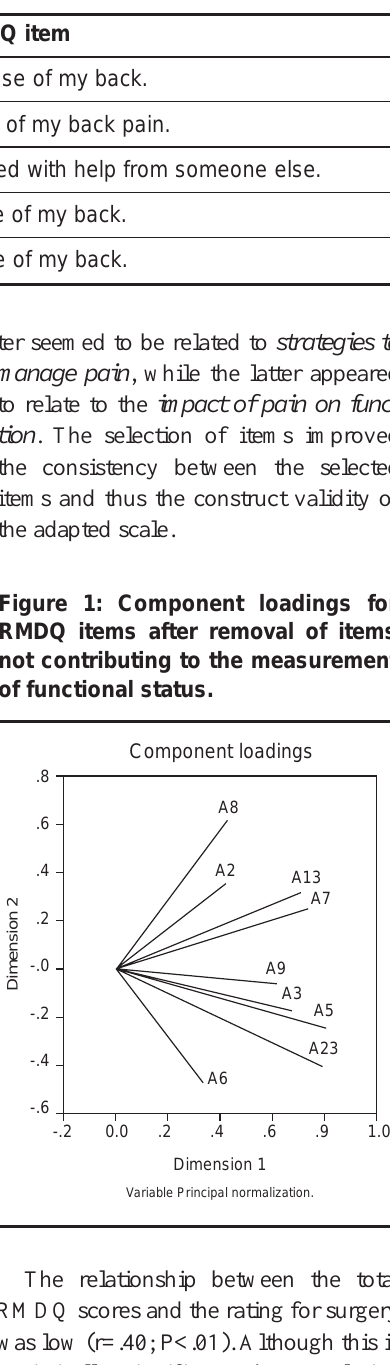
Table 2: Items excluded from the analysis of the RMDQ.